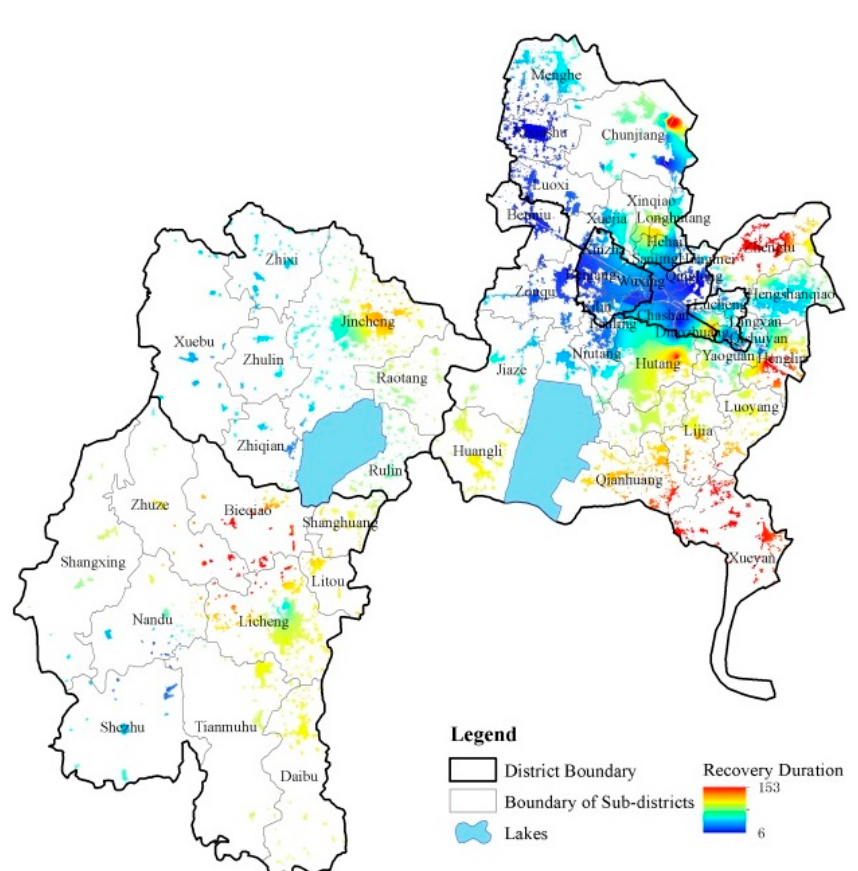
Figure 7. Time consumption for recovery within build-up area.